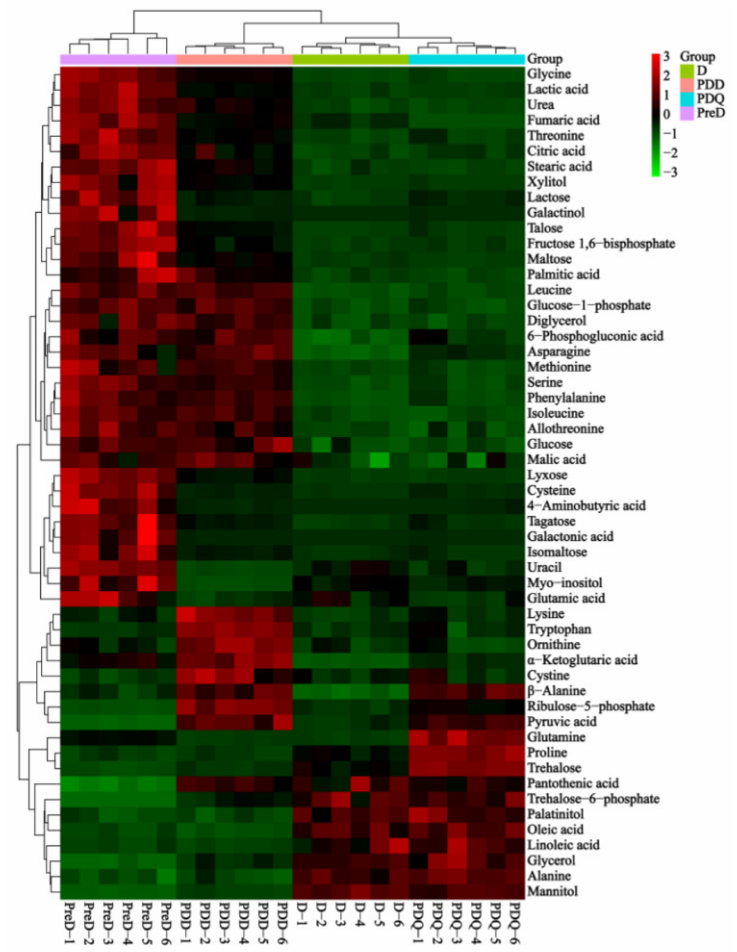
Figure 4. Hierarchical cluster analysis of all differential metabolites among pre-diapause (PreD), diapause (D), post-diapause quiescence (PDQ) and post-diapause developmental larvae (PDD) of Sitodiplosis mosellana . Red and green colors represent increased and decreased metabolites relative to the median metabolic level (black),